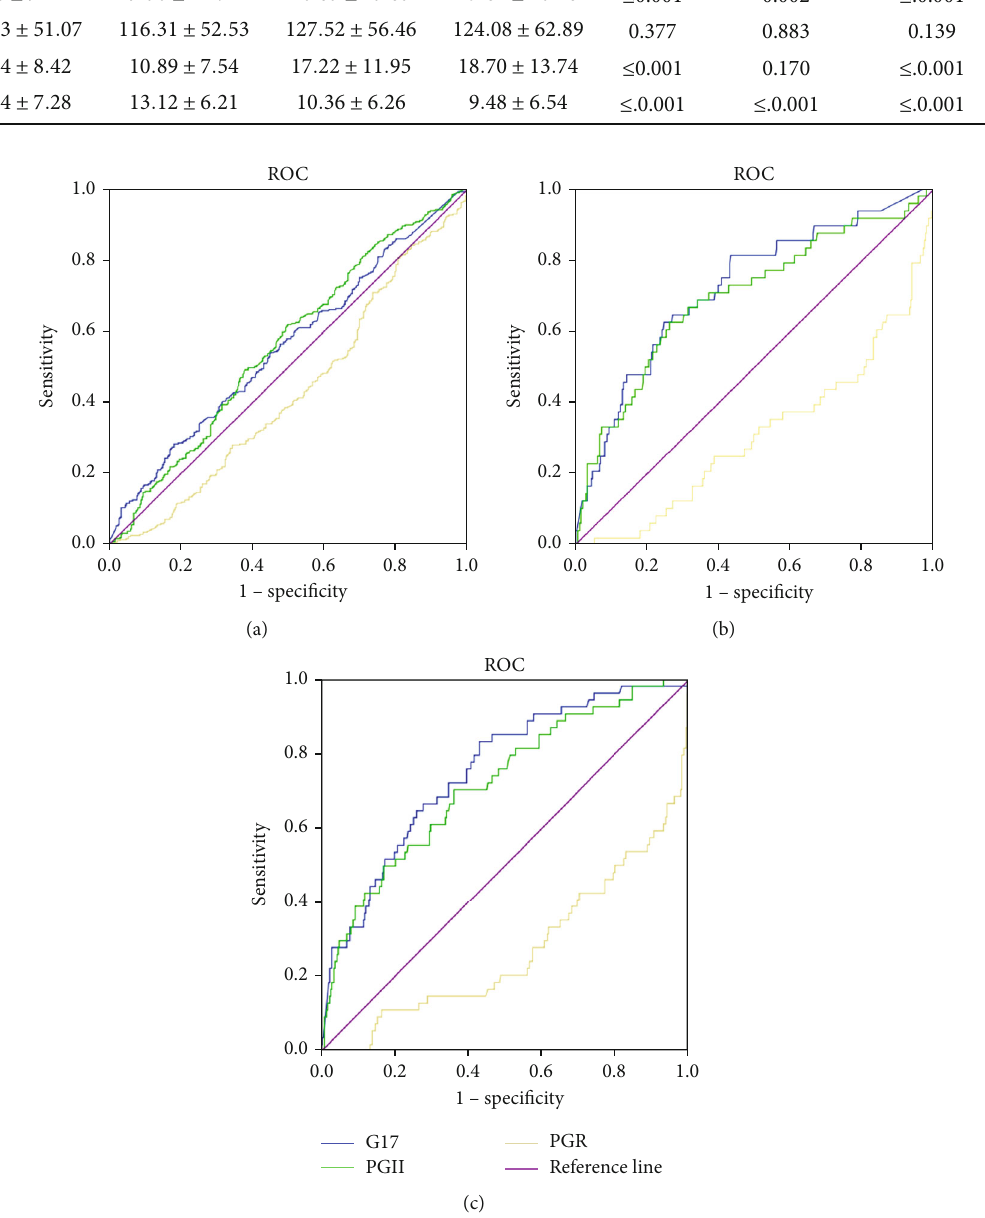
Figure 1: Determination of the cuto ff values of G-17, PGII, and PGR and diagnostic value. (a) ROC curve of NAG and CAG. G-17: AUC is 0.555 (CI 0.512-0.598), YI is 0.101, and cuto ff value is 9.25; PGII: AUC is 0.561 (CI 0.518-0.604), YI is 0.120, and cuto ff value is 7.06; PGR: AUC is 0.571 (CI 0.528-0.614), YI is 0.135, and cuto ff value is 12.07. (b) ROC curve of CG and IN. G-17 : AUC is 0.722 (CI 0.642-0.801), YI is 0.379, and cuto ff value is 3.86; PGII: AUC is 0.697 (CI 0.611-0.783), YI is 0.362, and cuto ff value is 11.92; PGR: AUC is 0.687 (CI 0.604-0.771), YI is 0.328, and cuto ff value is 8.26. (c) ROC curve of CG and GC. G-17: AUC is 0.753 (CI 0.684-0.821), YI is 0.403, and cuto ff value is 3.89; PGII: AUC is 0.717 (CI 0.642-0.793), YI is 0.342, and cuto ff value is 9.16; PGR: AUC is 0.729 (CI 0.650-0.807), YI is 0.357, and cuto ff value is 14.14. AUC: area under the receiver operating characteristic curve; YI: Youden index; CI: con fi dence